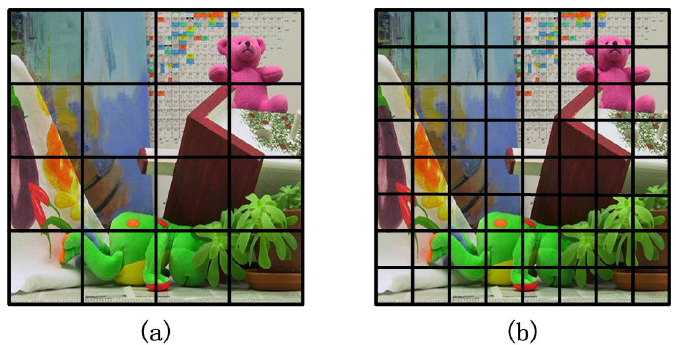
Figure 5. Schematic diagram of meshing: ( a ) image divided by 4 × 4 sub-regions, ( b ) image divided by 8 × 8